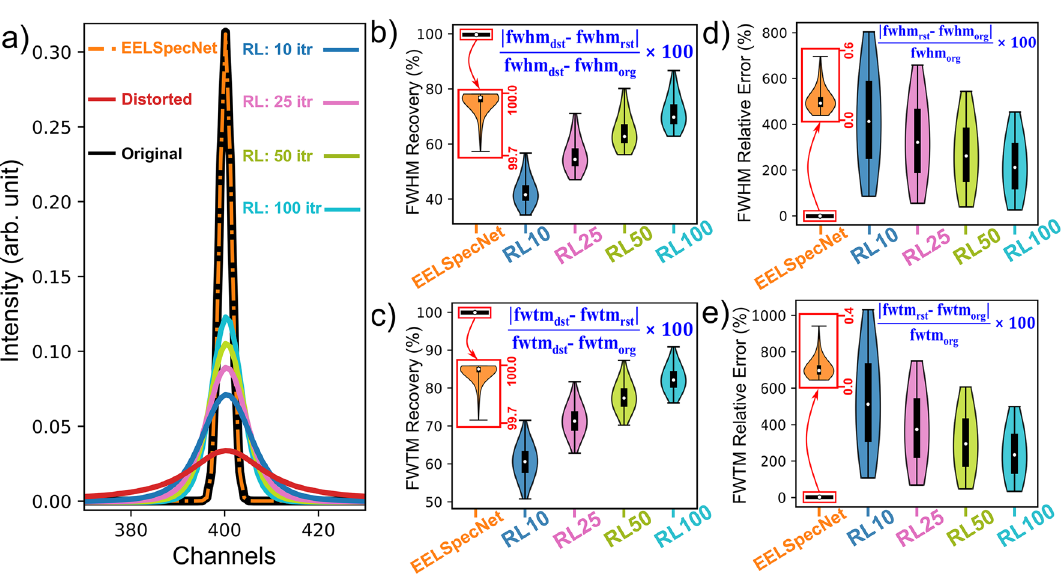
Figure 5. ( a ) An example of a ZLP restoration using EELSpecNet and RL (10, 25, 50, and 100 iterations). Violin plots demonstrating: ( b ) ZLP FWHM and ( c ) ZLP FWTM recovery rate, and ( d ) ZLP FWHM and ( e ) ZLP FWTM relative error. Corresponding equations are shown on each plot (Eq.